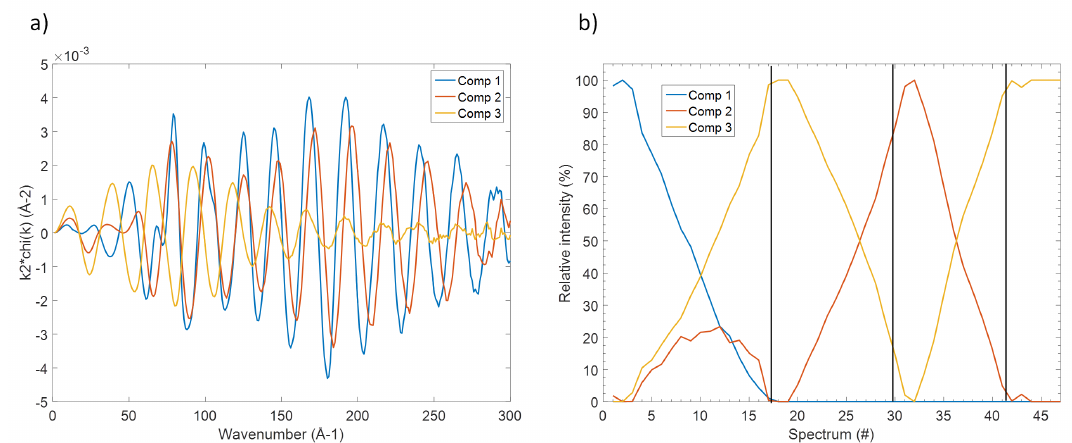
Figure 4. EXAFS spectral components ( a ) obtained by MCR-ALS analysis of the EXAFS operando spectra, and variation of their intensity ( b ) during electrochemical cycling. The vertical black lines represent the end of each process (first discharge, first charge, and second